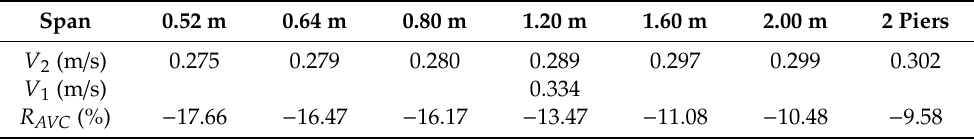
Table 5. R AVC of each